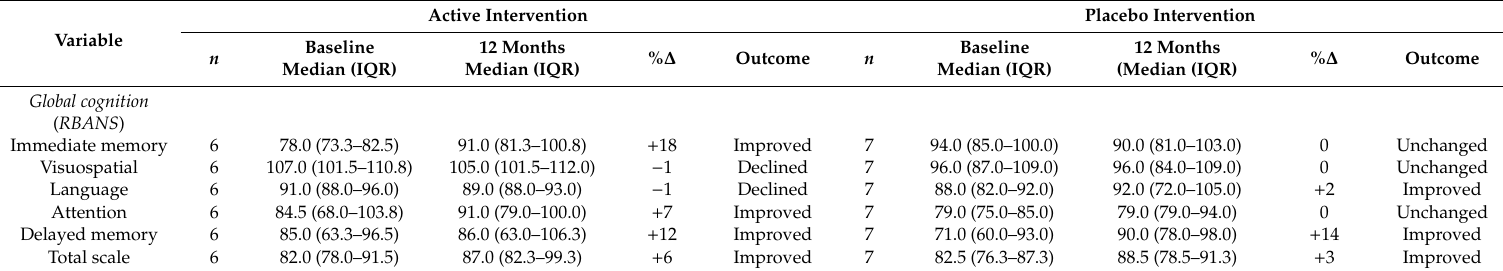
Table 5. Average percentage change in global cognition over 12 months between active and placebo intervention